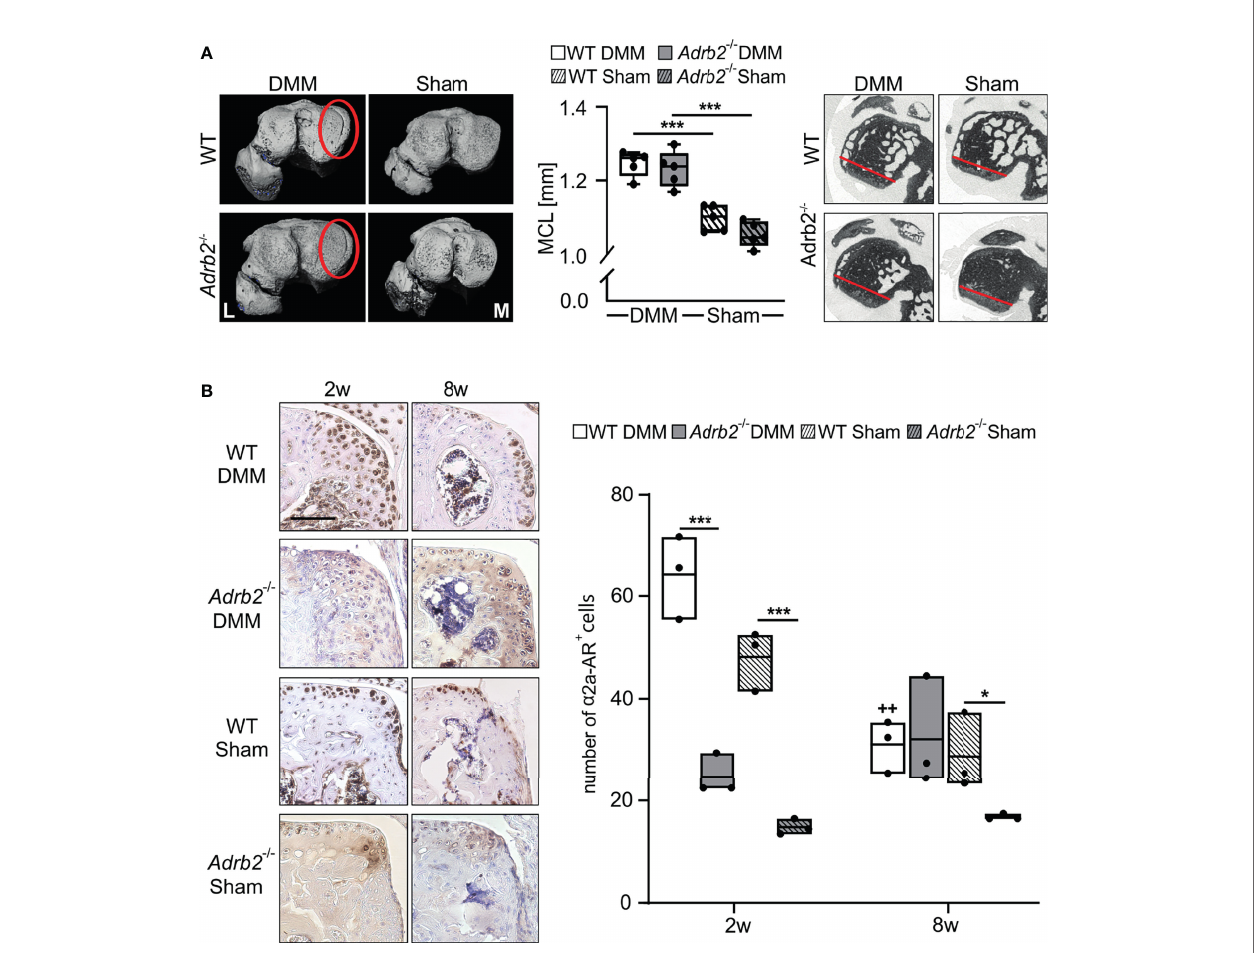
FIGURE 3 | Analysis of the region of osteophyte formation in the medial condyles. (A) Representative micro-CT images of the medial condyles with (DMM groups) or without (Sham groups) osteophytes 8 weeks after surgery. The quanti fi cation of the medial condyle lengths in WT and Adrb2 -/- mice 8 weeks after surgery and representative micro-CT images display the medial condyle. Data are presented as box plots with whiskers. Each black circle represents an individual mouse (n=5 per group). Signi fi cant p-values are presented as ***p ≤ 0.001 for comparisons between groups. (B) Immunohistochemical detection and quanti fi cation of a 2A-AR (dark brown) in the region of osteophyte formation in WT and Adrb2 -/- mice 2 and 8 weeks after DMM or Sham surgery (bar: 100 µm). Nuclei are counterstained with hematoxylin (in dark blue). Data are presented as box plots with whiskers. Each black circle represents an individual mouse (n=3 per group). Signi fi cant p-values are presented as *p ≤ 0.05, ***p ≤ 0.001 for comparisons between groups. ++ p ≤ 0.01 when compared to 2 weeks WT